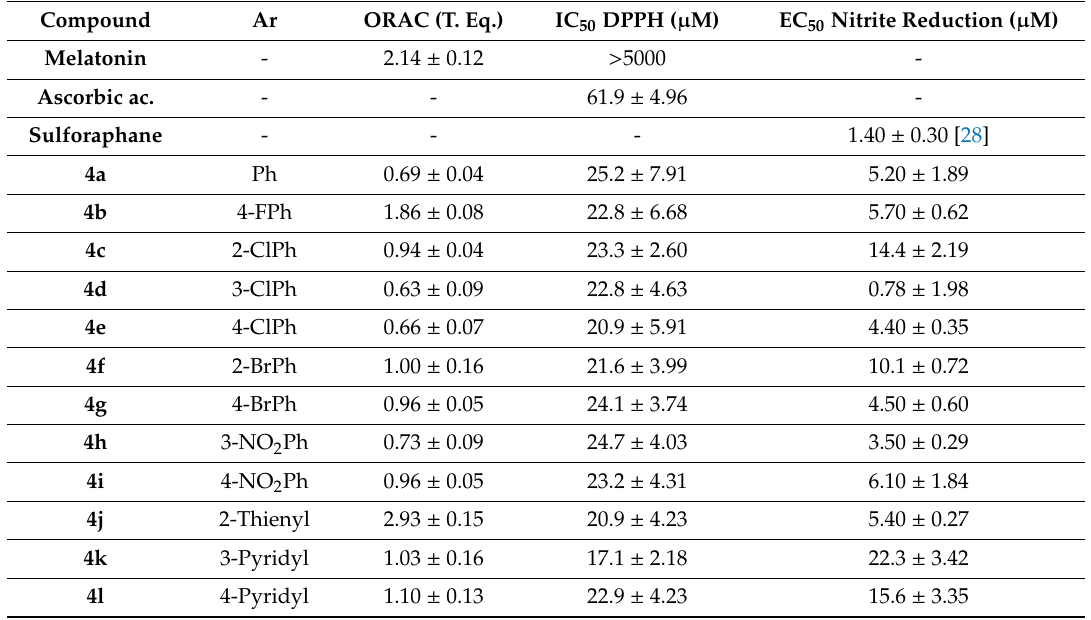
Table 1. Antioxidant and anti-inflammatory properties of derivatives 4a – l and reference compounds. Compound